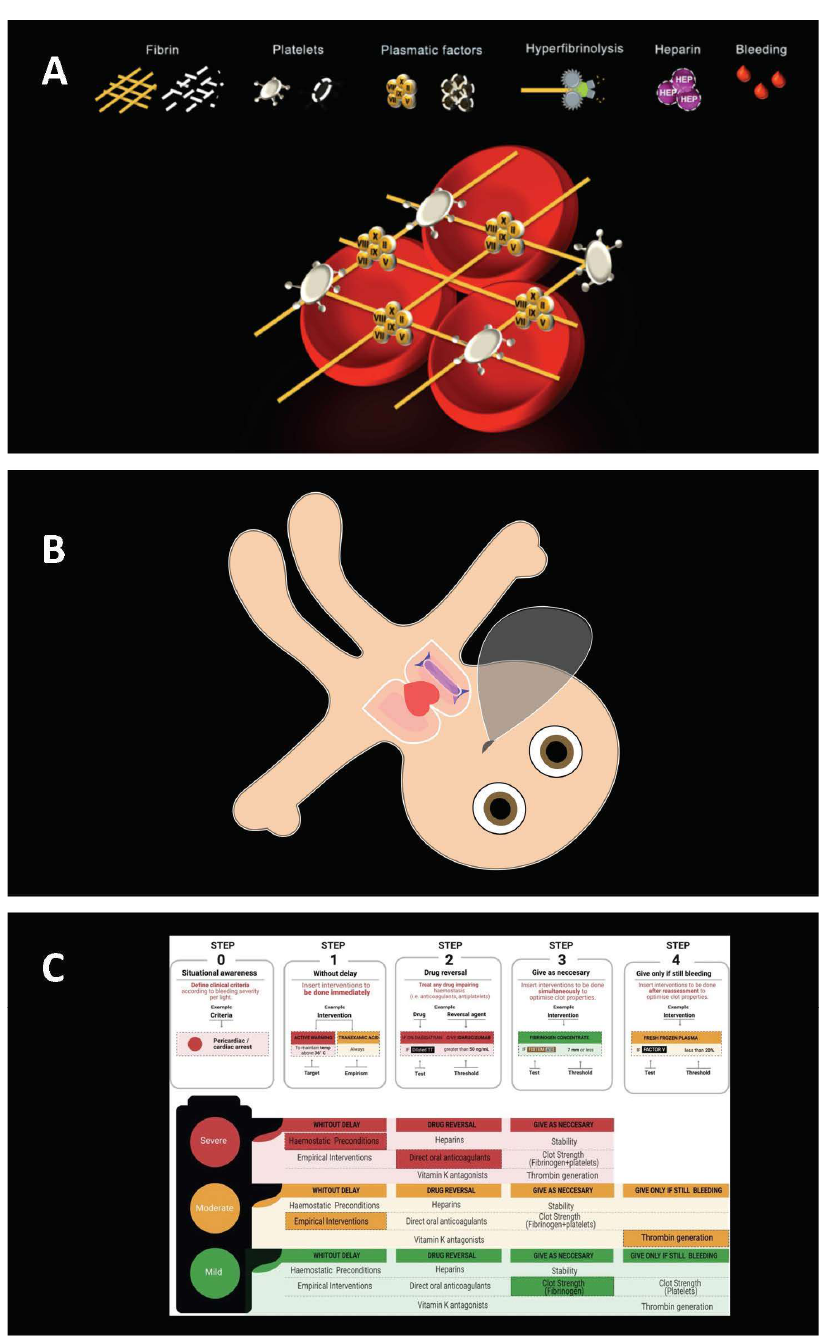
Figure 1. Presentation of the user-centered technologies. All were developed according to user- centered design principles. ( A ) A Visual Clot without pathologies is seen in the lower part of the image. The schematic icons displayed above represent the basic hemostatic components. For example, in the case of deficiency, components appear as dashed lines. ( B ) A Visual Patient with a high brain-activity index is represented by open eyes. The remaining vital signs are within the normal range. ( C ) Step-by-step design of Haemostasis Traffic Light. The cognitive aid can be adapted to local bleeding management